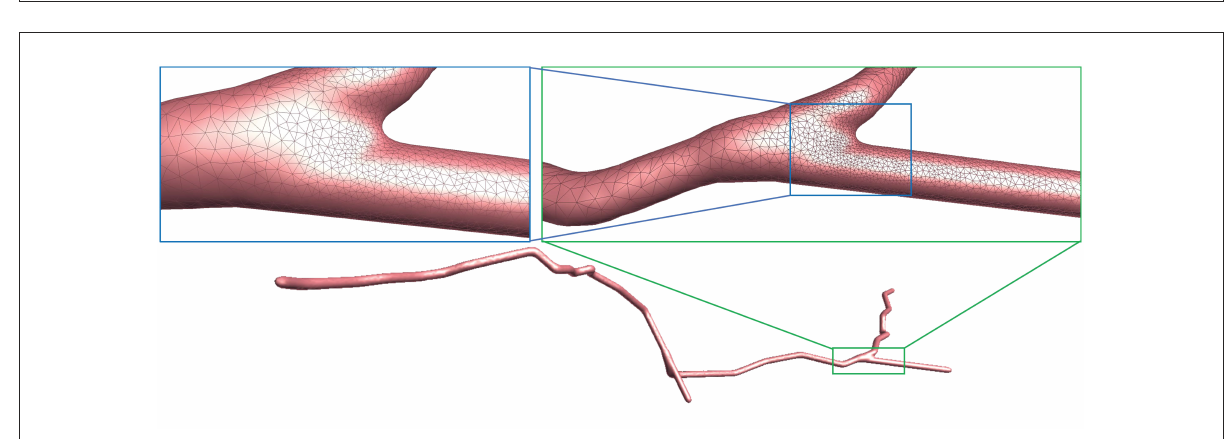
FIGURE10 Adaptive mesh vertex distributions in a bifurcating region. High-density vertices are placed at the bifurcating region to effectively capture geometrical